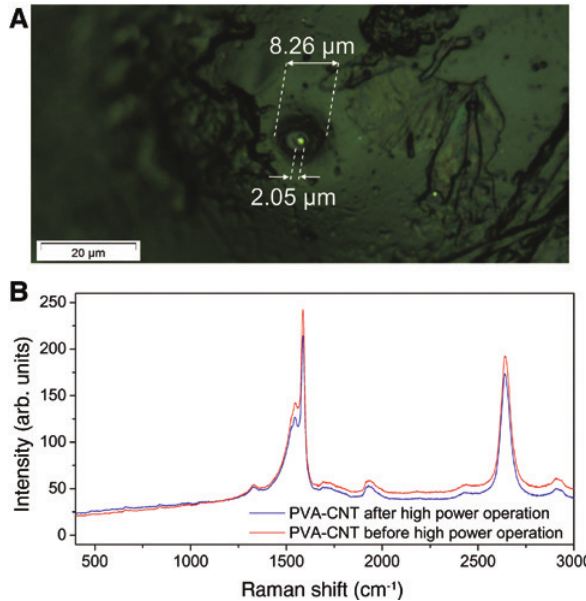
Figure 11: Microscopic pictures of the PVA film after a 24-h high- power